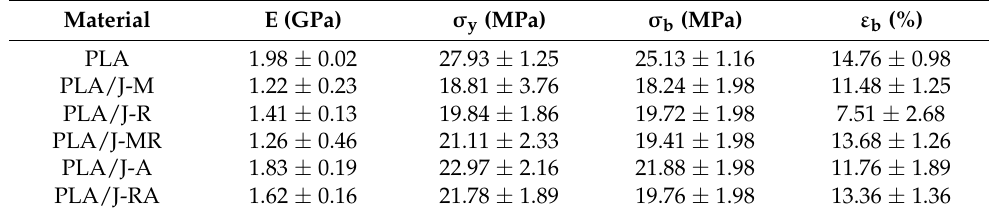
Table 2. Mechanical parameters of PLA and PLA composites.